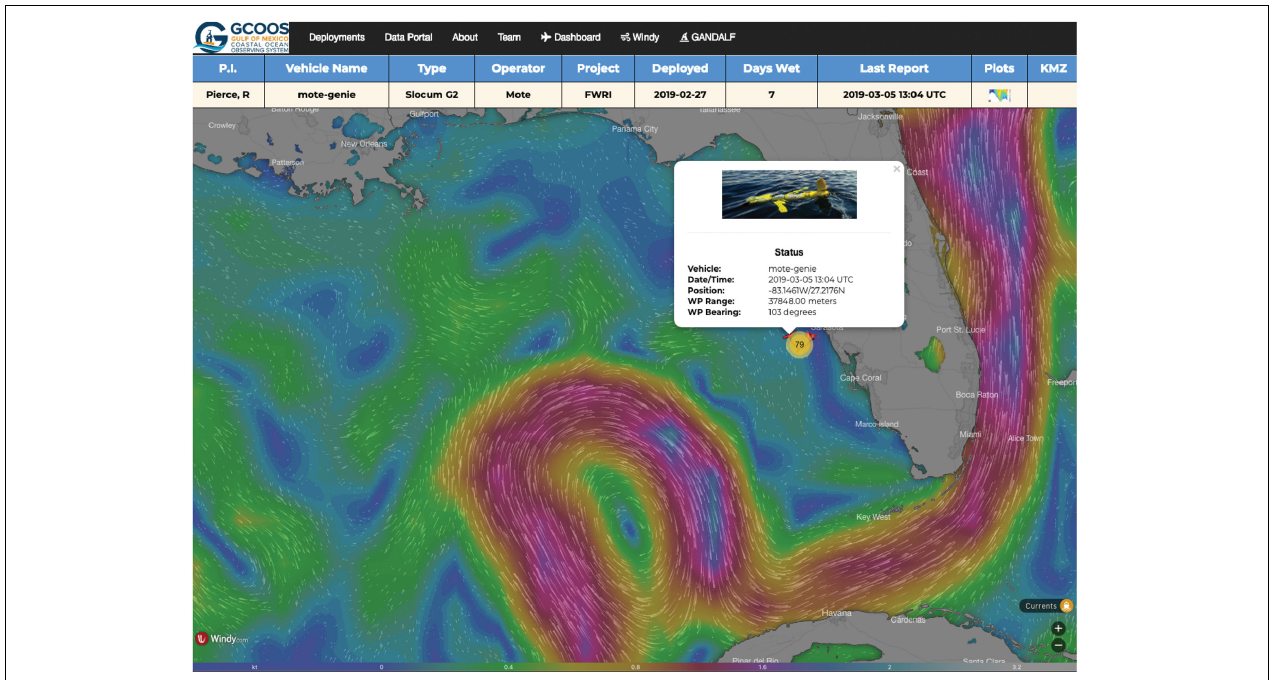
FIGURE 4 | GANDALF AUV piloting portal showing deployed vehicles and waypoints. Vehicles that have recently reported their positions are shown as green, vehicles that have not reported in 48 h are shown in red. Lack of communication can be caused by many factors but is typically a sign of rough seas and bad weather conditions. Image courtesy of